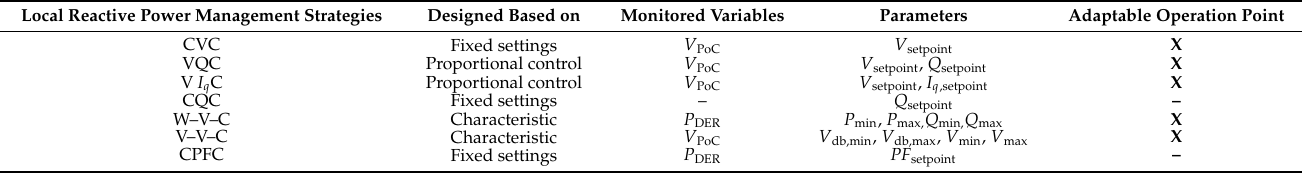
Table 2. Summary of the main characteristic of local reactive power control